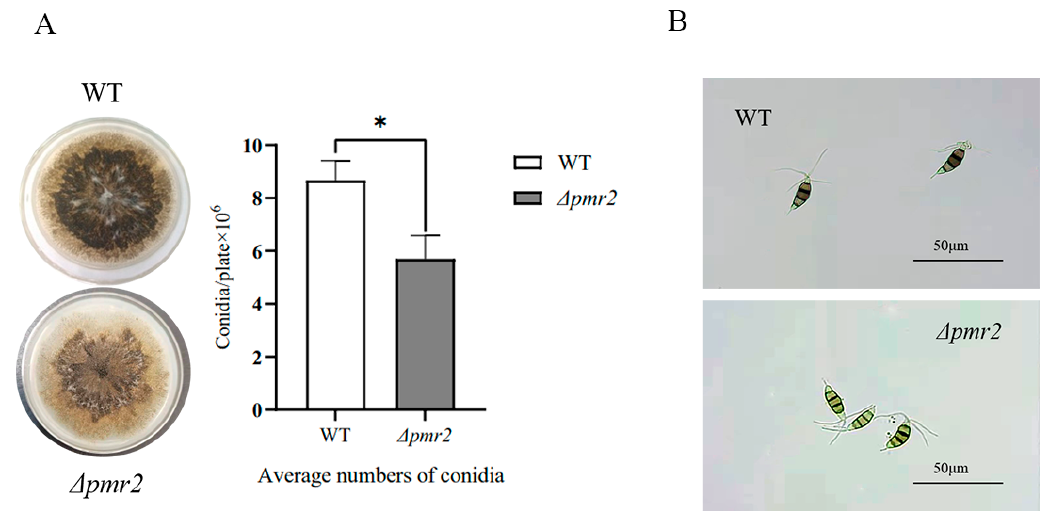
Figure 4. Effects of Pmr2 on melanin synthesis and conidia development. ( A ) Statistics of the number of conidia produced by WT and Δ pmr2 . The disruption of pmr2 reduced the production of conidia. Three biological replicates were conducted for both strains. Error bars represent standard